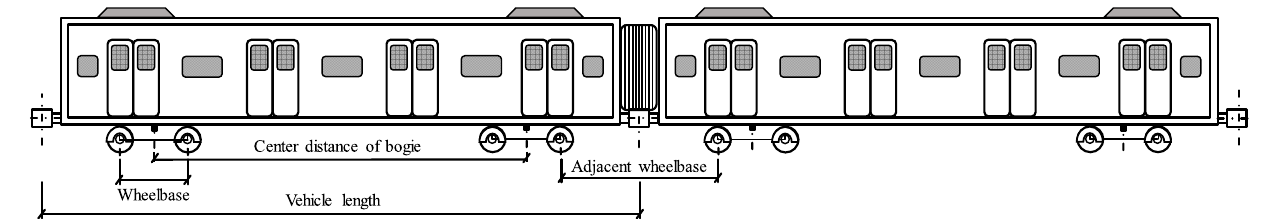
Figure 4. Schematic diagram of B-type metro.